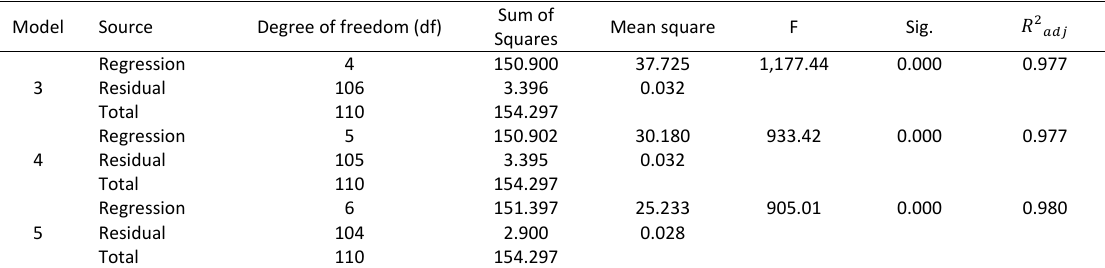
Table 5: Analysis of variance of other generated